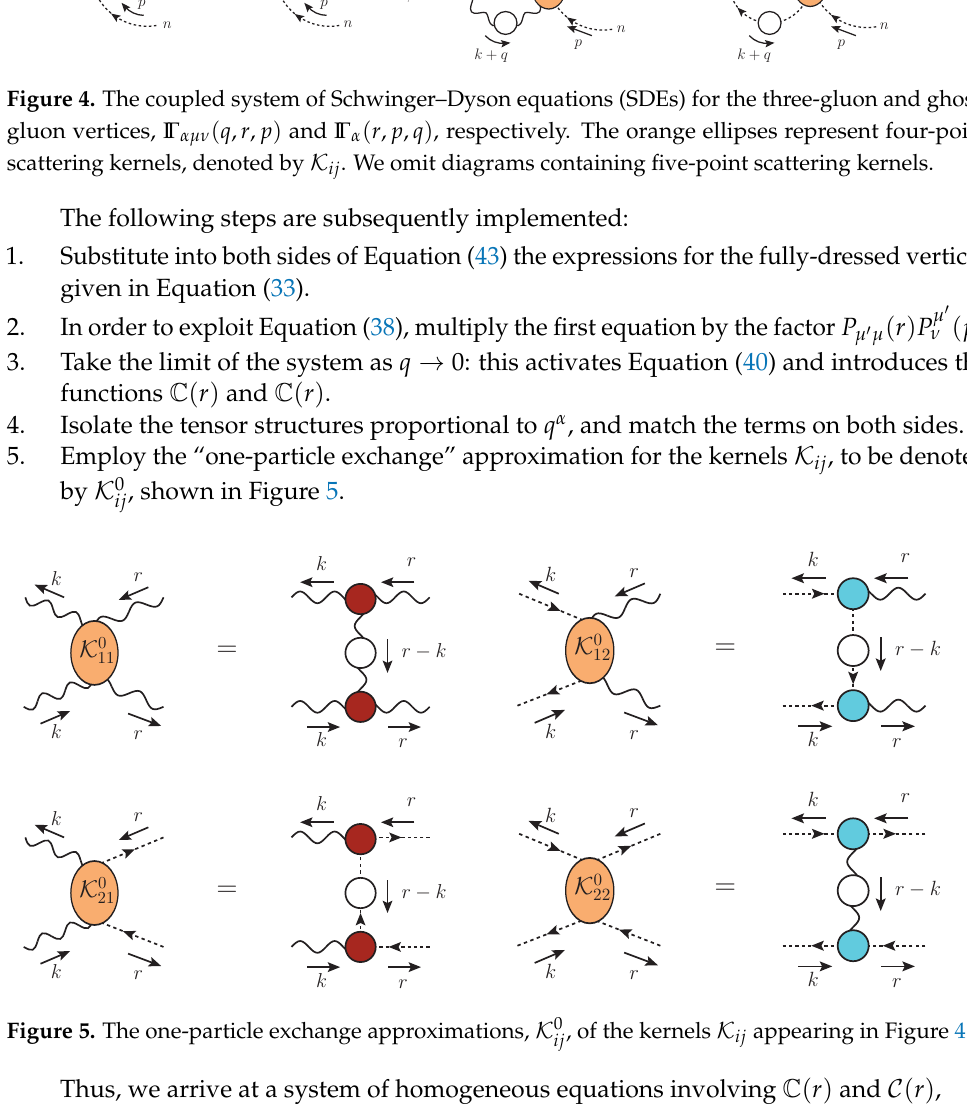
Figure 5. The one-particle exchange approximations, Thus, we arrive at a system of homogeneous equations involving C ( r ) and